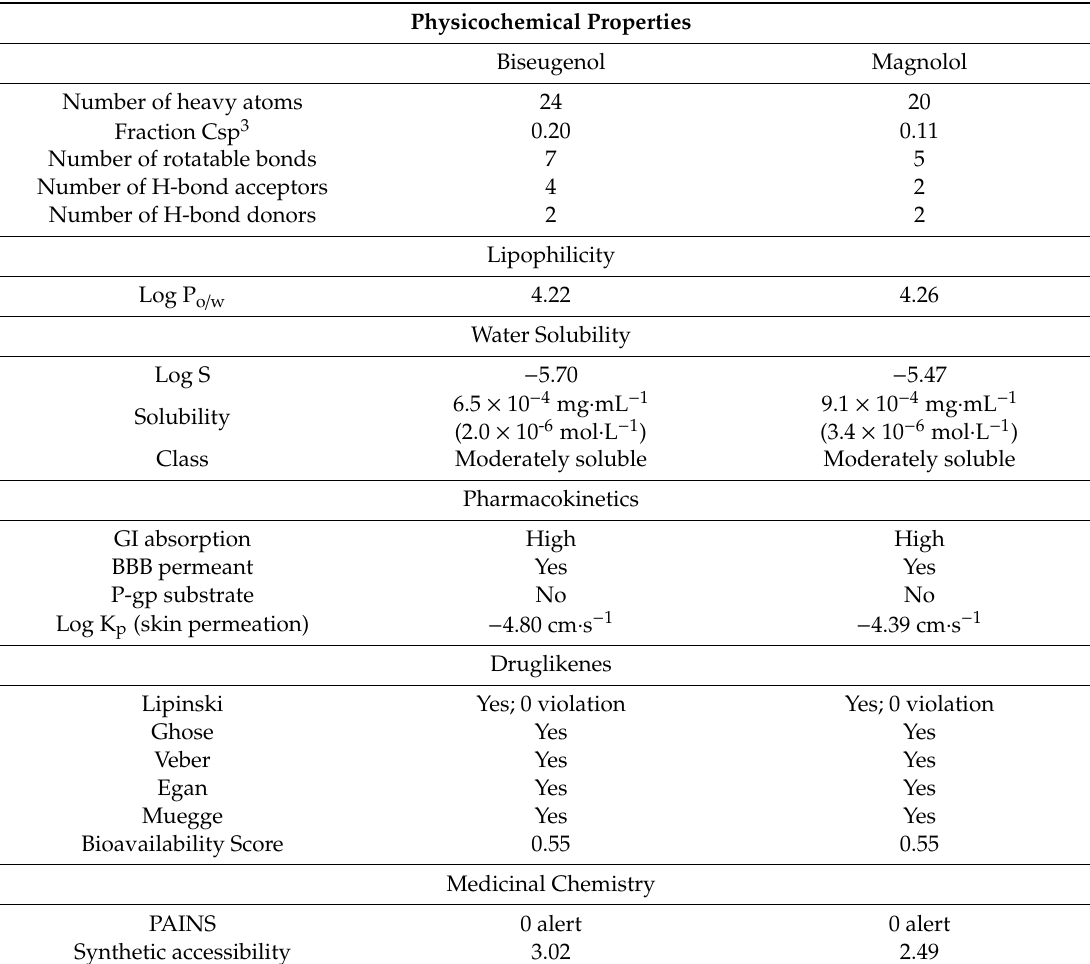
Table 1. Physicochemical properties and ADME predictions [10] for biseugenol and magnolol. Physicochemical Properties